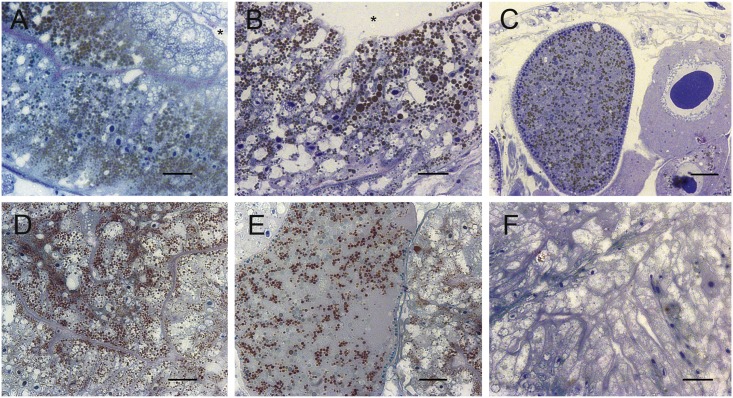
Transverse Sections of Ophyotrocha cyclops.Tissues were stained with osmium tetroxide and toluidine blue. The gut epithelium of specimens fixed upon collection (A), after 13 days (B), after one month (D) and after three months (F) are shown, as well as oocytes of the same specimens after 13 days (C) and one month (E). Lipid inclusions are stained in black with osmium tetroxide. The gut lumen is indicated by an asterisk. Scale bars: 40 μm.